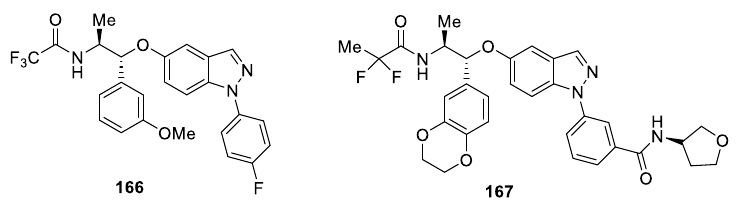
Figure 50. Chemical structures of 6 indazole ether-based derivatives 166 and 167 .